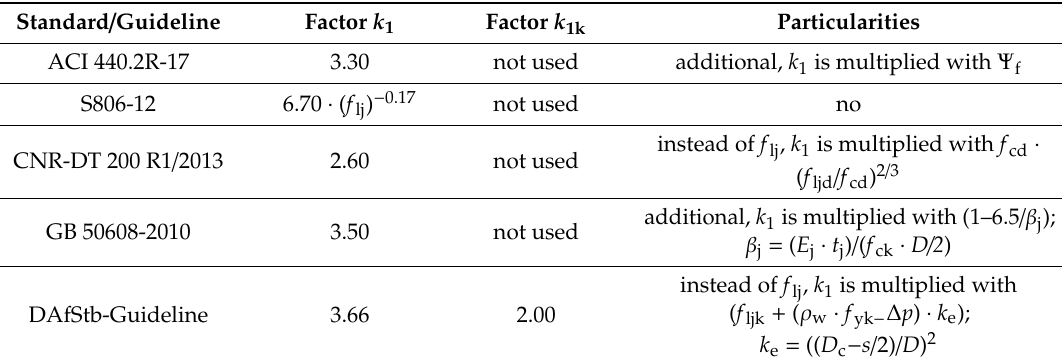
Figure 5. Confinement pressure f lj depicted as a function of CFRP rupture strain ε FRP (derived from flat coupon tests) when the modulus of the composite material is E j = 600 GPa. Table 5. The factor k 1 determined in the considered codes and